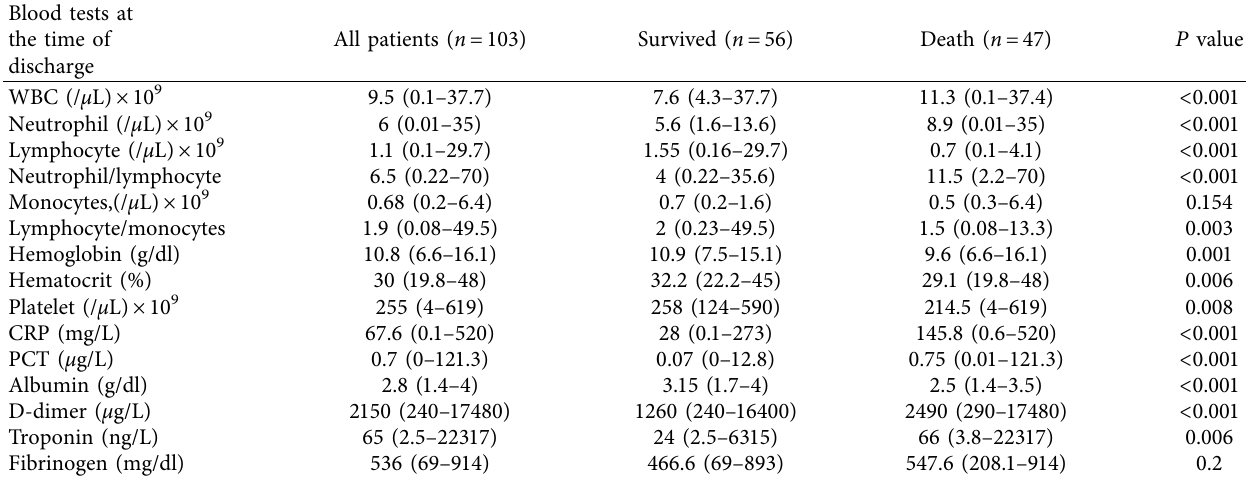
Table 6: Kaplan–Meier analysis and blood parameters predicting mortality after